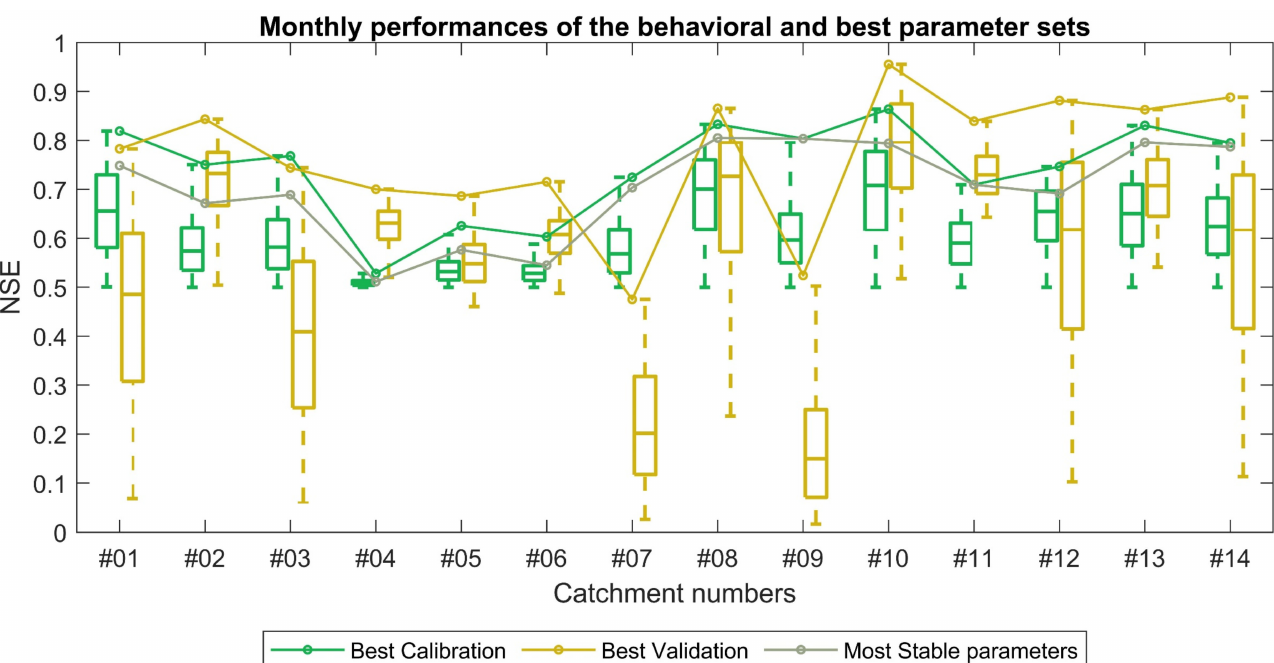
Figure 3. The ranges of monthly NSE values derived from the confined parameter sets during calibration and the corresponding NSE ranges during the validation period derived from the confined parameter sets; and the monthly NSE derived from parameter sets of best calibration, best validation, and most stable parameter sets for each